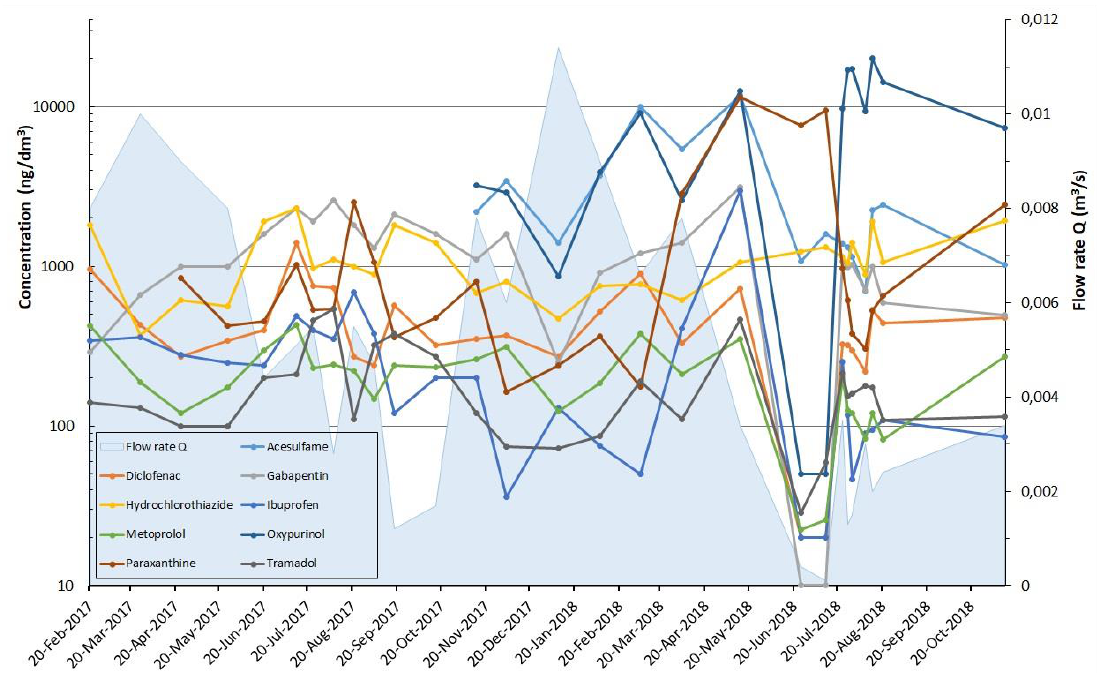
Figure 4. Monitoring results on Dolni Kralovice profile. Table 5. Dolni Kralovice Profile — number of samples